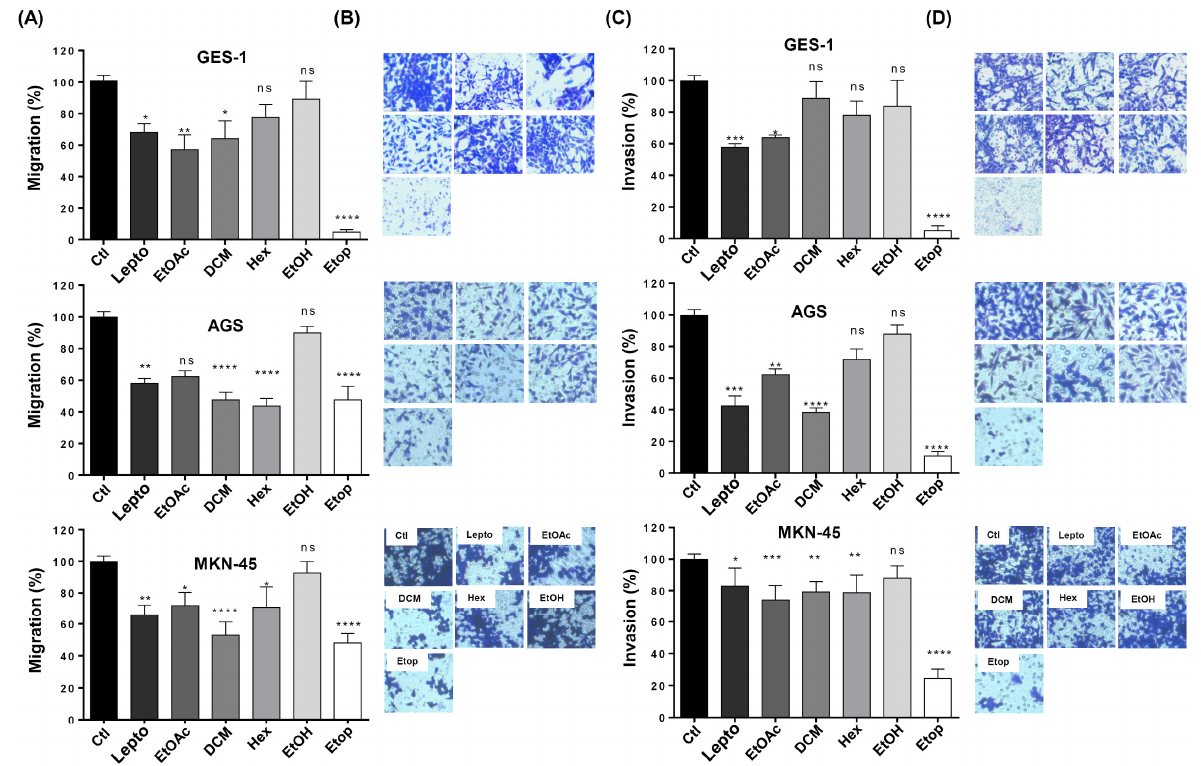
Figure 5. Effect of L. rivularis flower extracts on the migration and invasion potential of gastric cells. GES-1, AGS, and MKN-45 gastric cells were treated with the extracts (DCM 5 µg/mL, EtOAc 5 µg/mL, Hex 10 µg/mL, or EtOH 15 µg/mL), leptocarpin (Lepto) 5 µg/mL, or Etoposide 50 µM (Etop) for 24 h and then harvested and seeded into the upper compartment of the Boyden’s migration/invasion chamber (see Material and Methods section). The number of cells that moved into the lower chamber represented the migrating/invading cells. ( A , C ) Bars represent the percentage of the migration ( A ) or invasion ( C ) of GES-1, AGS, and MKN-45 cells treated with the indicated extracts, compared to the control cells (100% migration/invasion). Data represent means ± S.D. of three independent experiments (* p < 0.05, ** p < 0.01, *** p ≤ 0.001, and **** p ≤ 0.0001, ns: non-significant). ( B , D ) Representative pictures of the migration ( B ) and invasion ( D ) assays in GES-1, AGS, and MKN-45 cells are shown (magnification ×